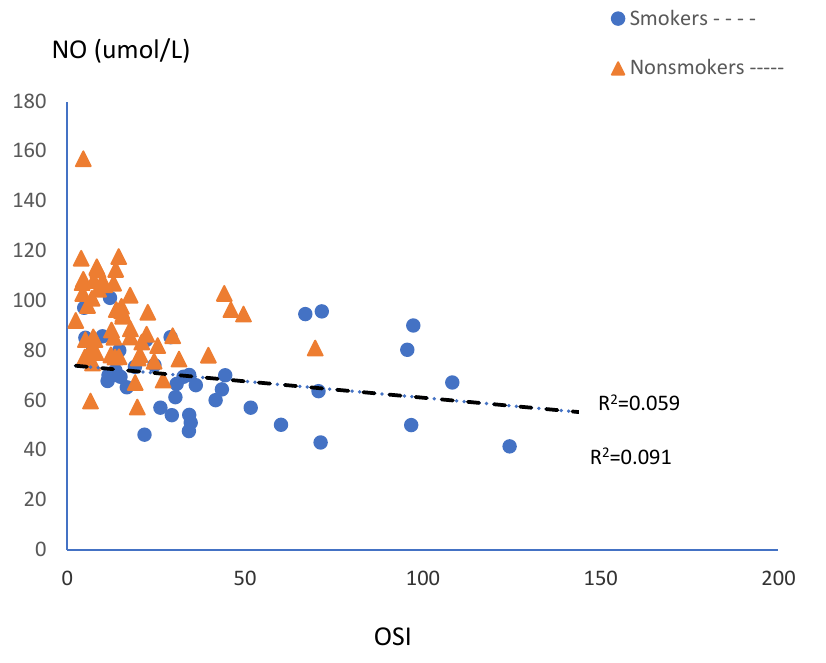
Figure 3. Correlations between serum NO and OSI levels in the subgroups of smoking (n = 42) and non-smoking pregnant women (n = 57). Table 4. Relations between studied nitric oxide parameters and oxidative stress markers in the subgroups of smoking (n = 42) and non-smoking pregnant women (n = 57).